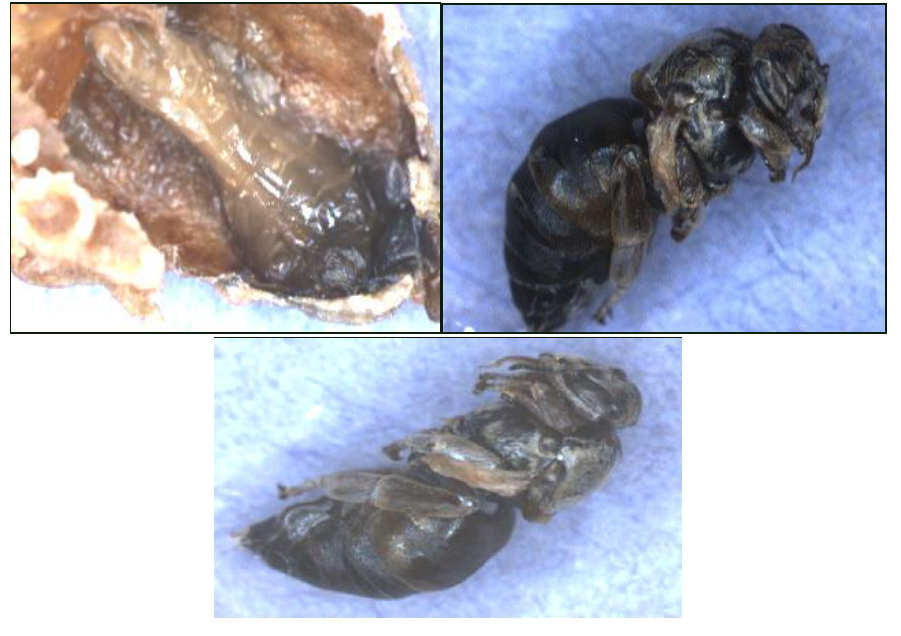
Figure 4. Examples of queen larvae from unemerged queen cells. The queens are representative of those that did not emerge when reared in colonies where pollen was contaminated with chlorpyrifos alone or with added fungicide (Pristine ®